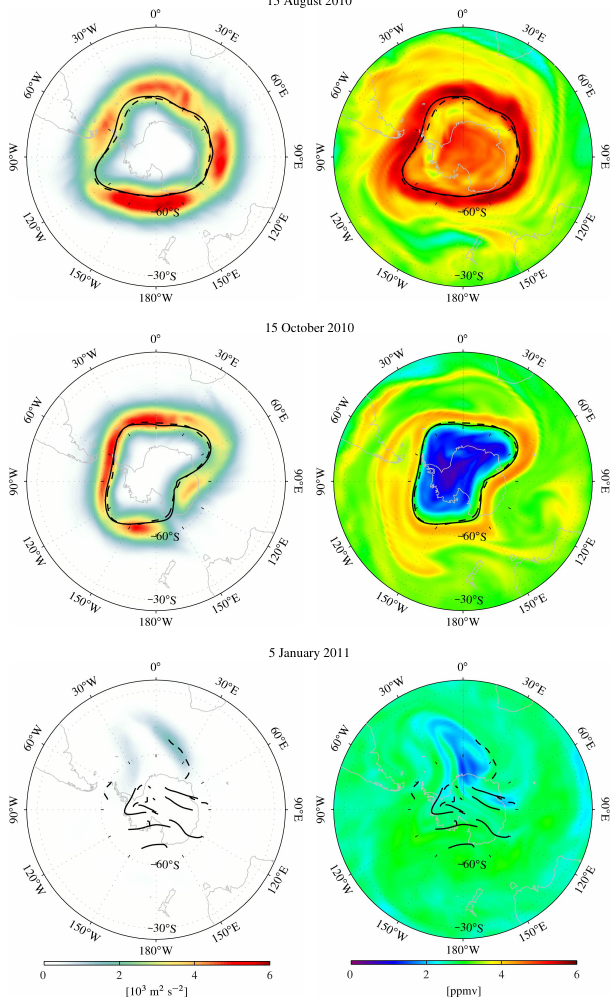
Fig. 2. Same as Fig. 1, but over the austral polar region on two days in 2010 and one day in